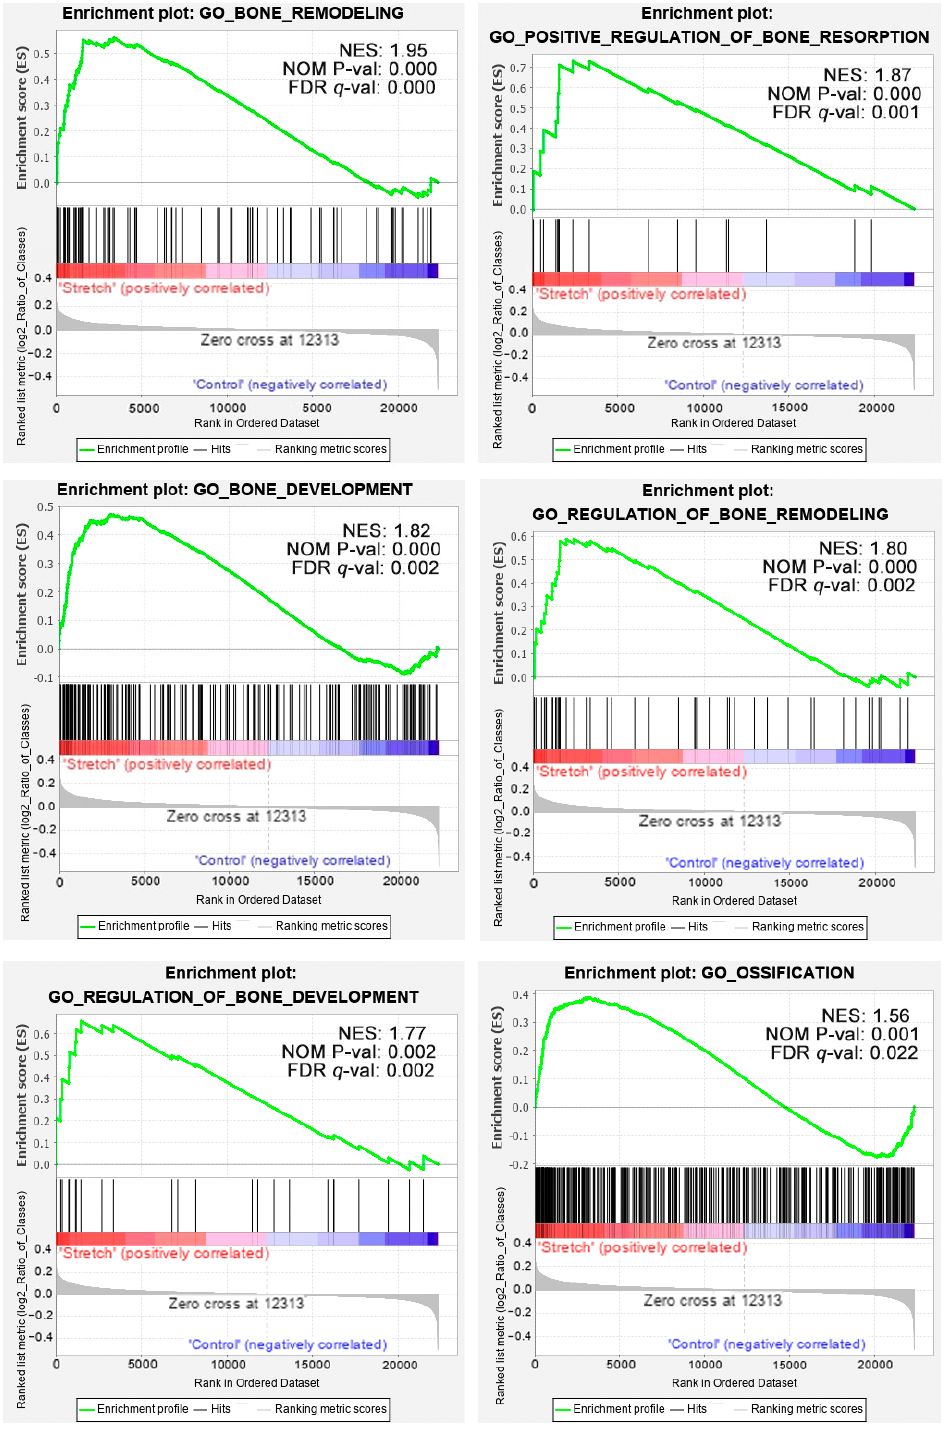
Figure 6. Enrichment plots from GSEA. GO terms of bone remodelling, positive regulation of bone resorption, bone development, regulation of bone remodelling, regulation of bone development, and ossification are significantly enriched in the distraction group.